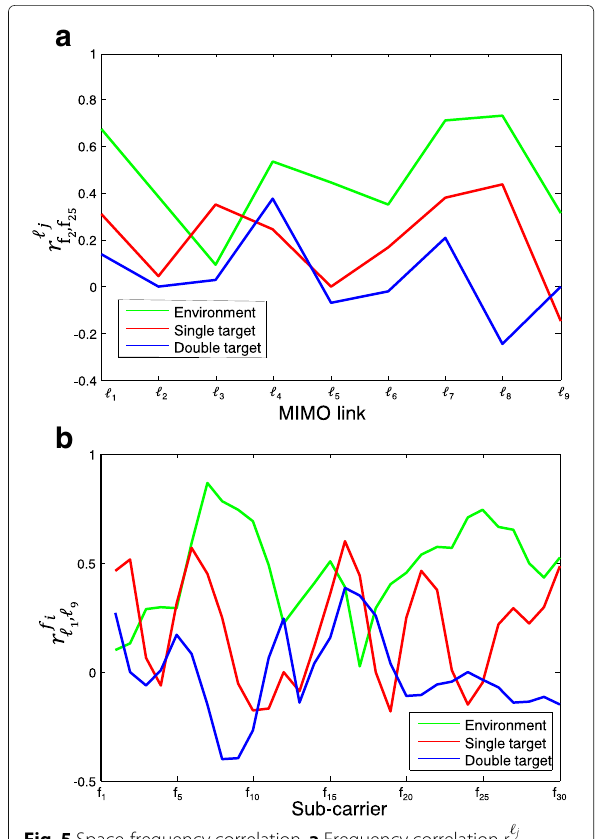
Fig. 5 Space-frequency correlation. a Frequency correlation r versus all links. b Space correlation r f i (cid:2)